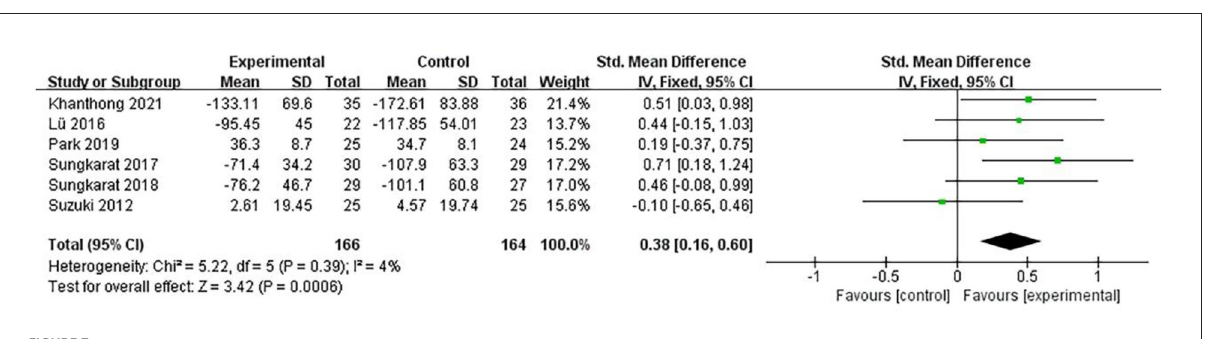
FIGURE7 The influence of exercise interventions on executive